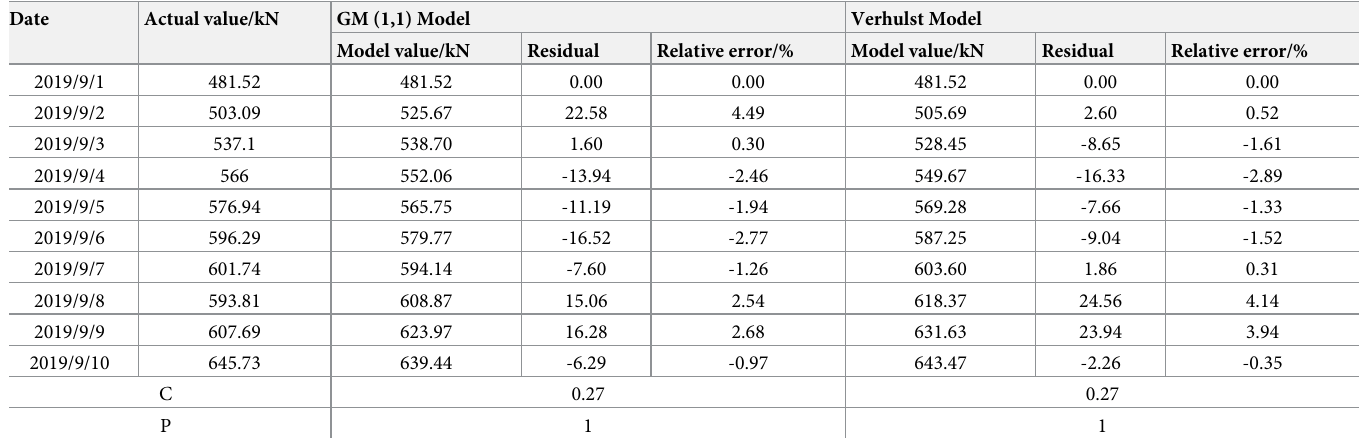
Table 5. ZG51-3 grey prediction model results.